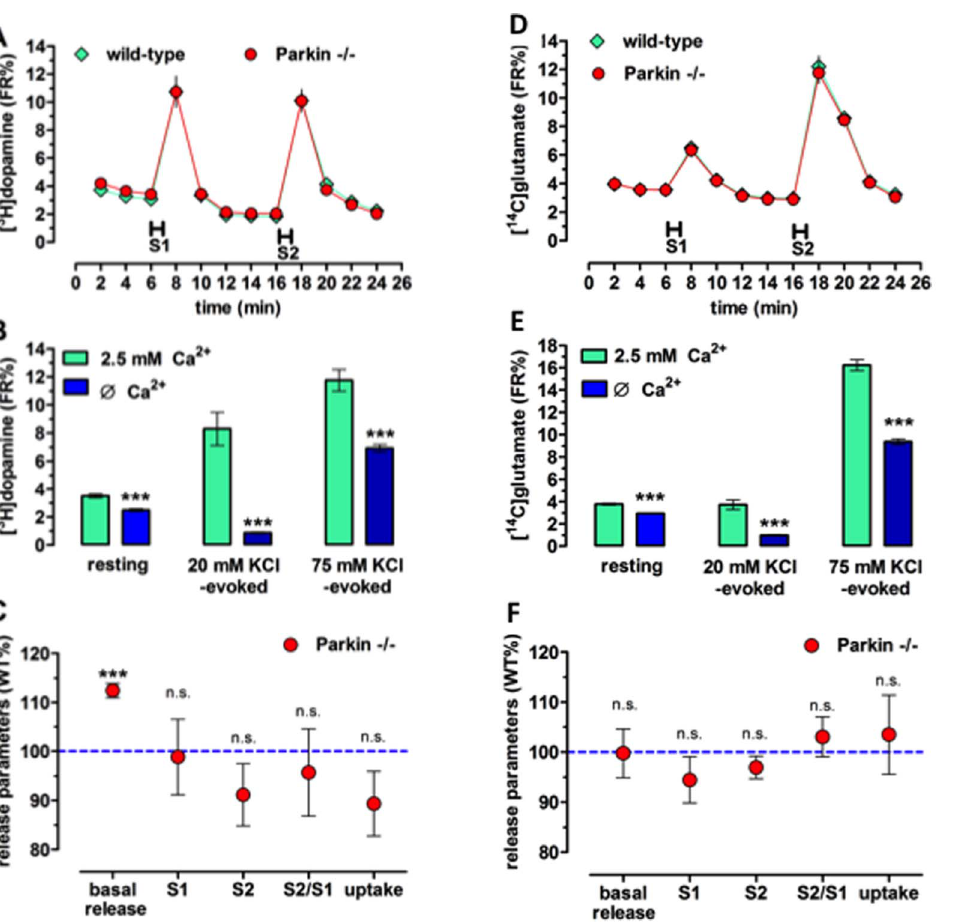
Fig . 5. Basal rather than stimulated [ 3 H]dopamine release is increased in striatal synaptosomes of parkin 2 / 2 versus wild-type mice, whereas [ 14 C]glutamate release is unchanged. Time course of the averaged time course of [ 3 H]dopamine release (A) and [ 14 C]glutamate release (D) from wild-type and parkin 2 / 2 mice. S1, S2: stimulation for 1 min with 20 and 75 mM KCl. Ca 2 + -dependence of the resting and stimulated release of [ 3 H]dopamine (B) and [ 14 C]glutamate (E). Low-calcium experiments were carried out in the presence of 100 nM CaCl 2 and 10 mM MgCl 2 . Release and uptake parameters